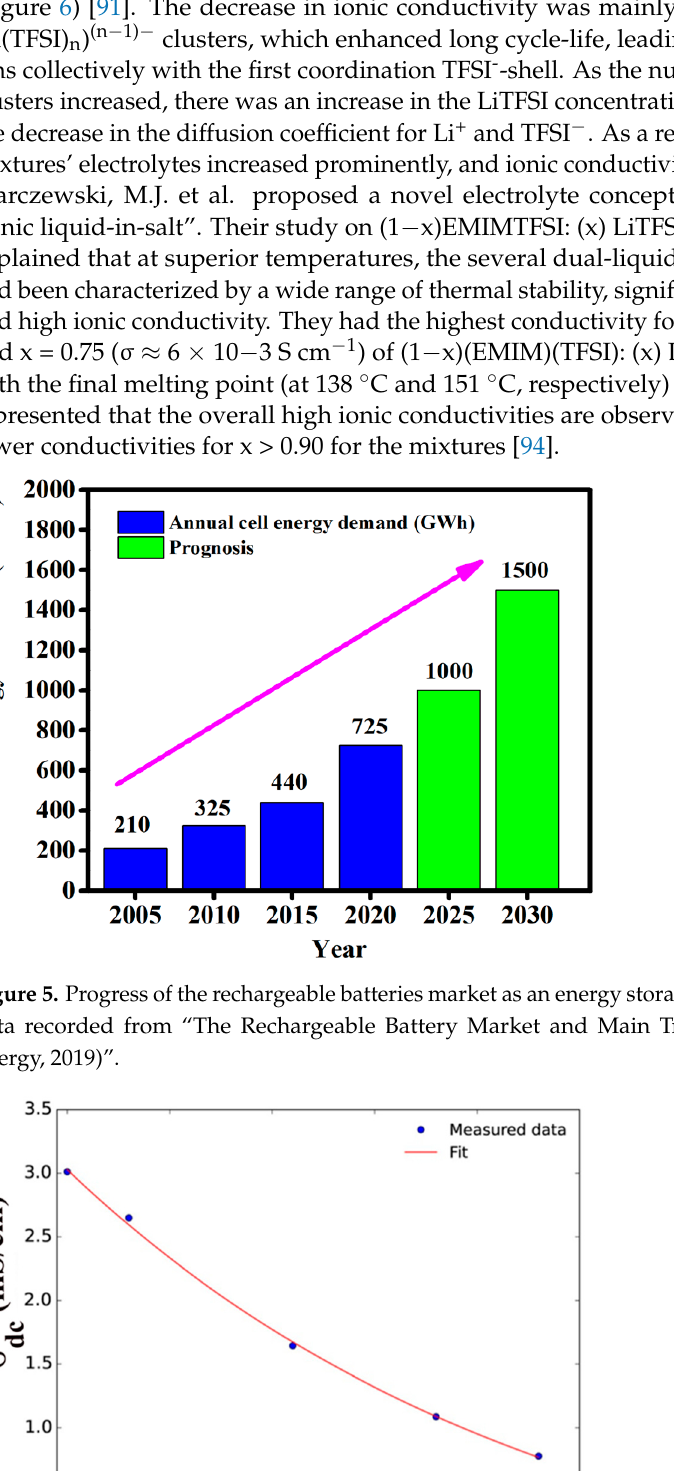
Figure 7. Comparison of ionic conductivities obtained for the Li x EMIM (1-x) TFSI (x = 0.70 and x = 0.97) system, data collected during heating and cooling, copyright; Reprinted with permission from Ref. [94]. Copyright 2014 The Royal Society of Chemistry. In other work, Balo, L. et al. reported synthesis and characterization of gel polymer electrolyte (GPE) based on polymer polyethylene oxide (PEO) and LiTFSI/(EMIM)(TFSI) for high-performance lithium polymer batteries (LPBs). This ILs mixed electrolyte exhibits high thermal stability of up to 300 °C, high ionic conductivity ( σ ≈ 2.08 × 10 − 4 S cm − 1 ), a